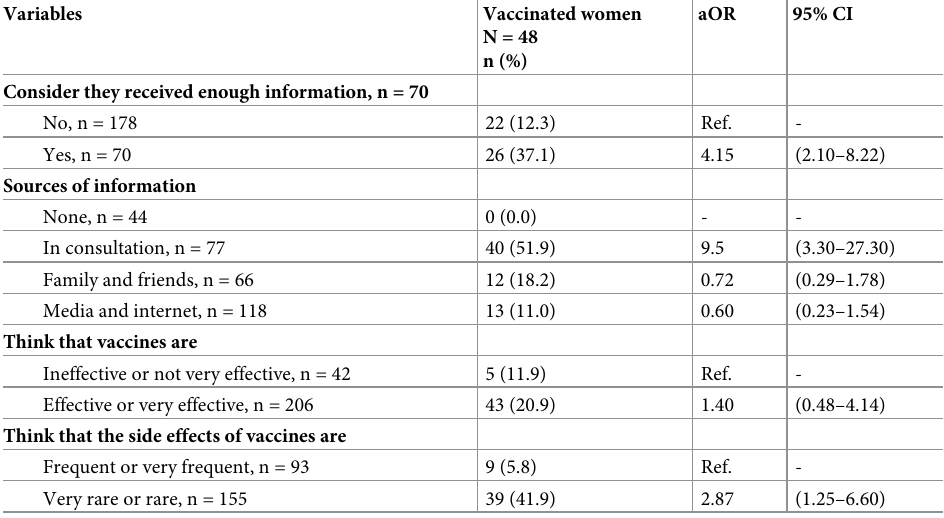
Table 3. Determinants associated with vaccination: Multivariate analysis including the variables associated with perception of vaccination (N = 248).